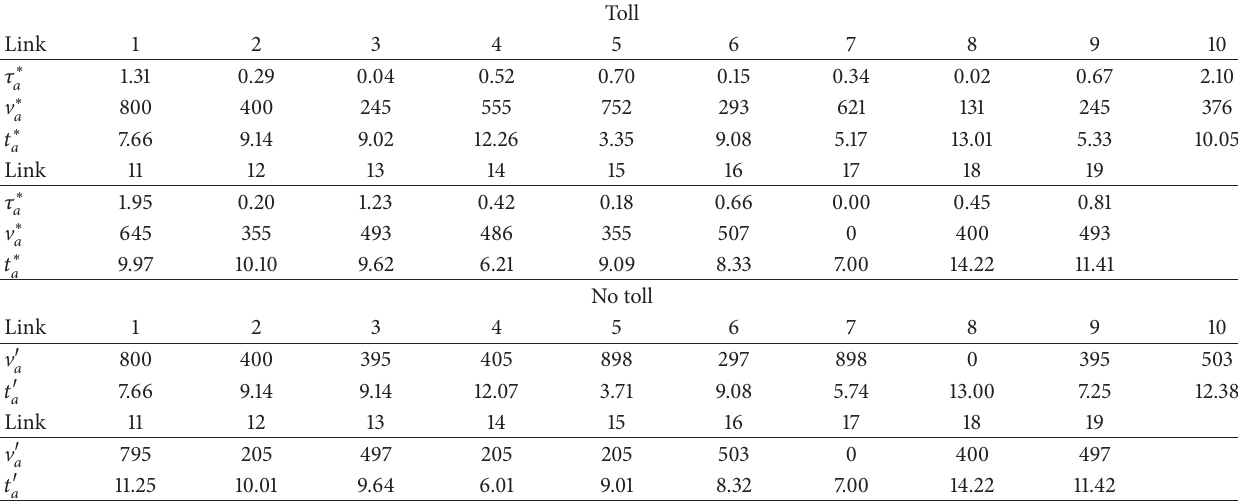
Table 3: Optimal toll scheme and the corresponding link flow (min/0.5, veh/hr,